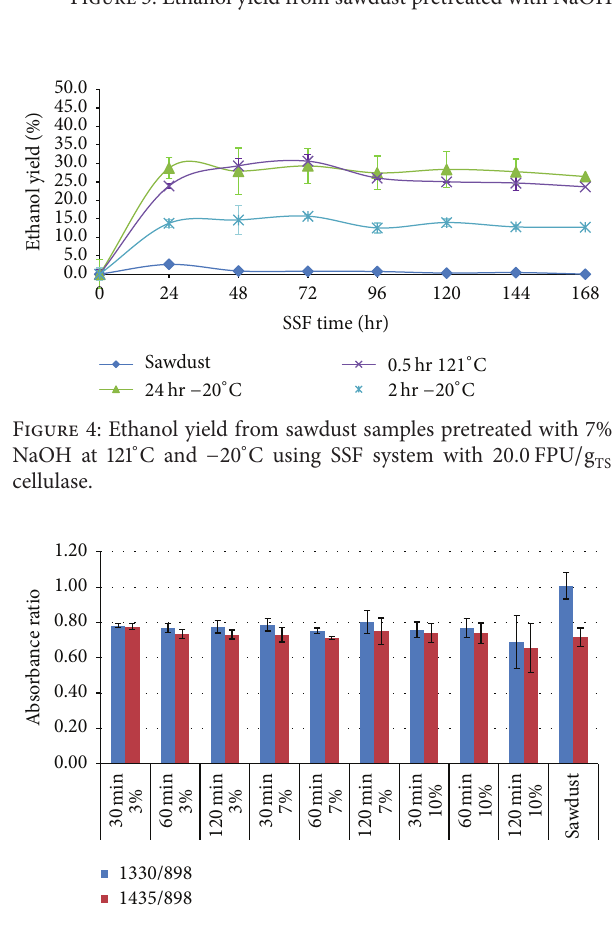
Figure 3: Ethanol yield from sawdust pretreated with NaOH at 60 ∘ C with enzyme dosage of (a) 9.1 FPU / g TS ; (b) 20.0 FPU / g TS .